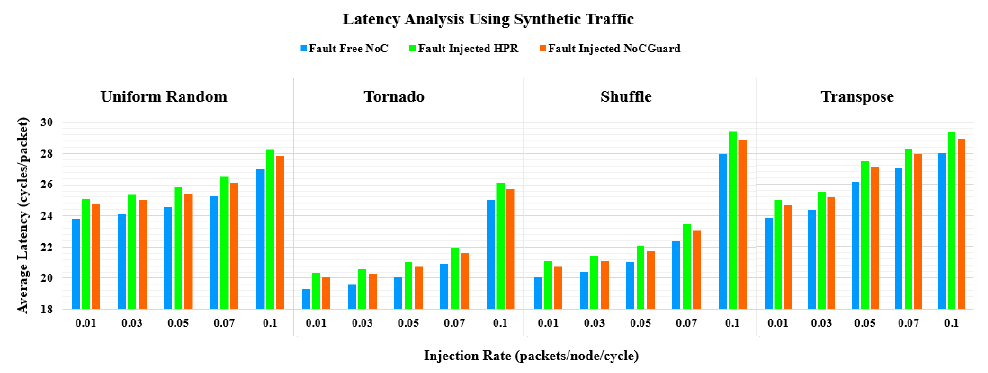
Figure 11. Average Latency for Synthetic Traffic.